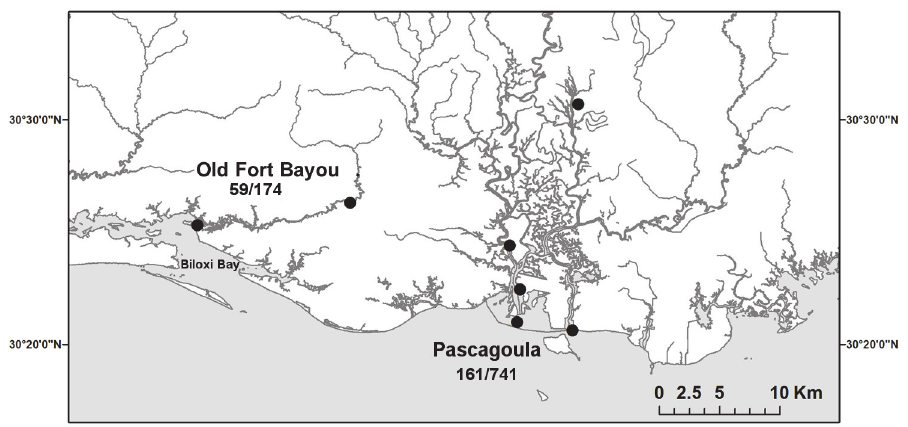
Fig 1. Map of the study are with the seven sites shown. Numbers indicate the total sample size (pre/post DWH) for Old Fort Bayou (OFB) and Pascagoula (PAS).